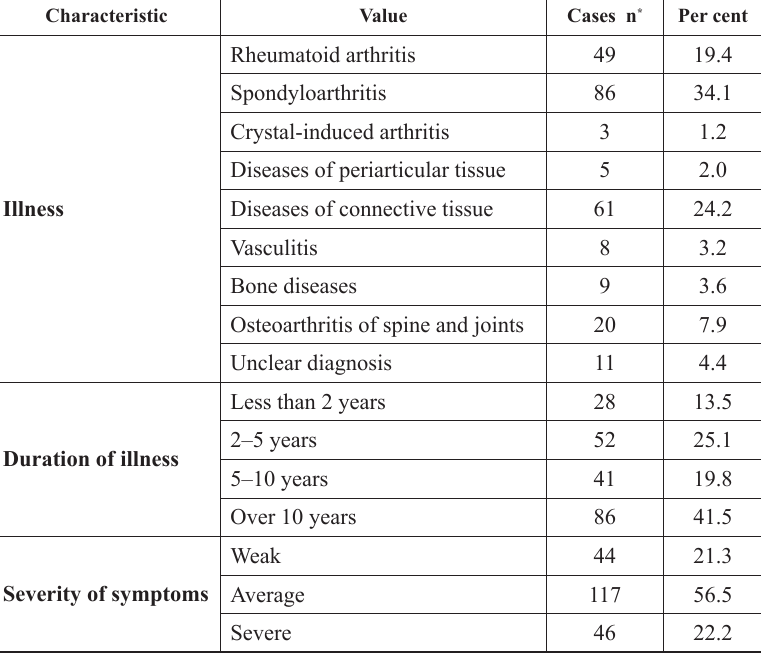
Table 2. Health Characteristics of